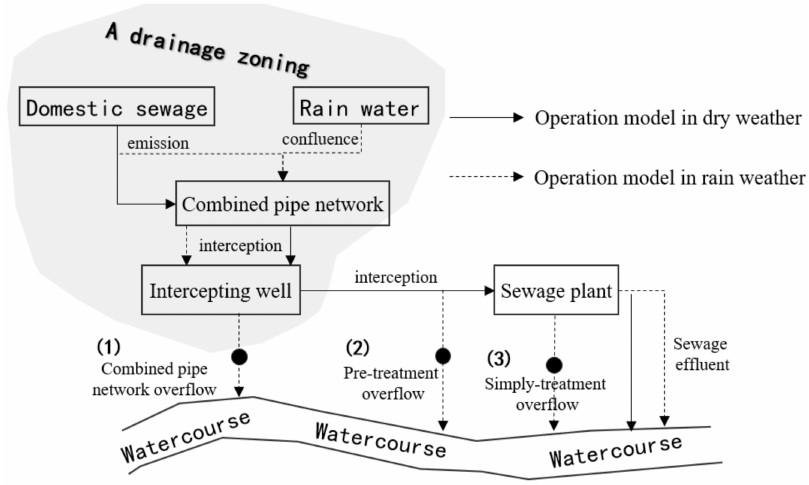
Figure 2. Overview of CSO drainage system in the study